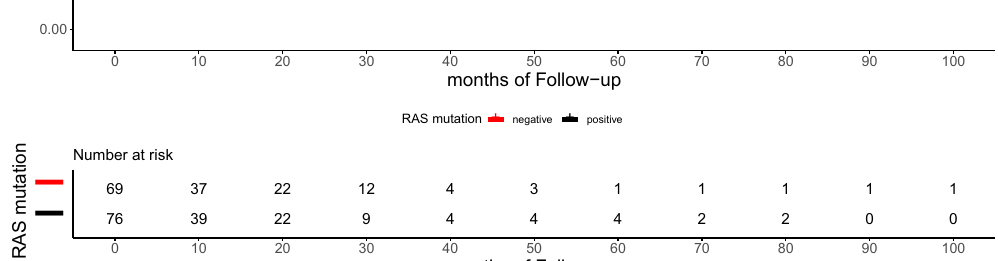
Figure 4. Kaplan–Meier curve for OS in 145 CRC patients by mutational status, including TP53 ( A ), RAS ( B ), APC ( C ), PIK3CA ( D ), SMAD4 ( E ), BRAF ( F ), ATM ( G ), and FBXW7